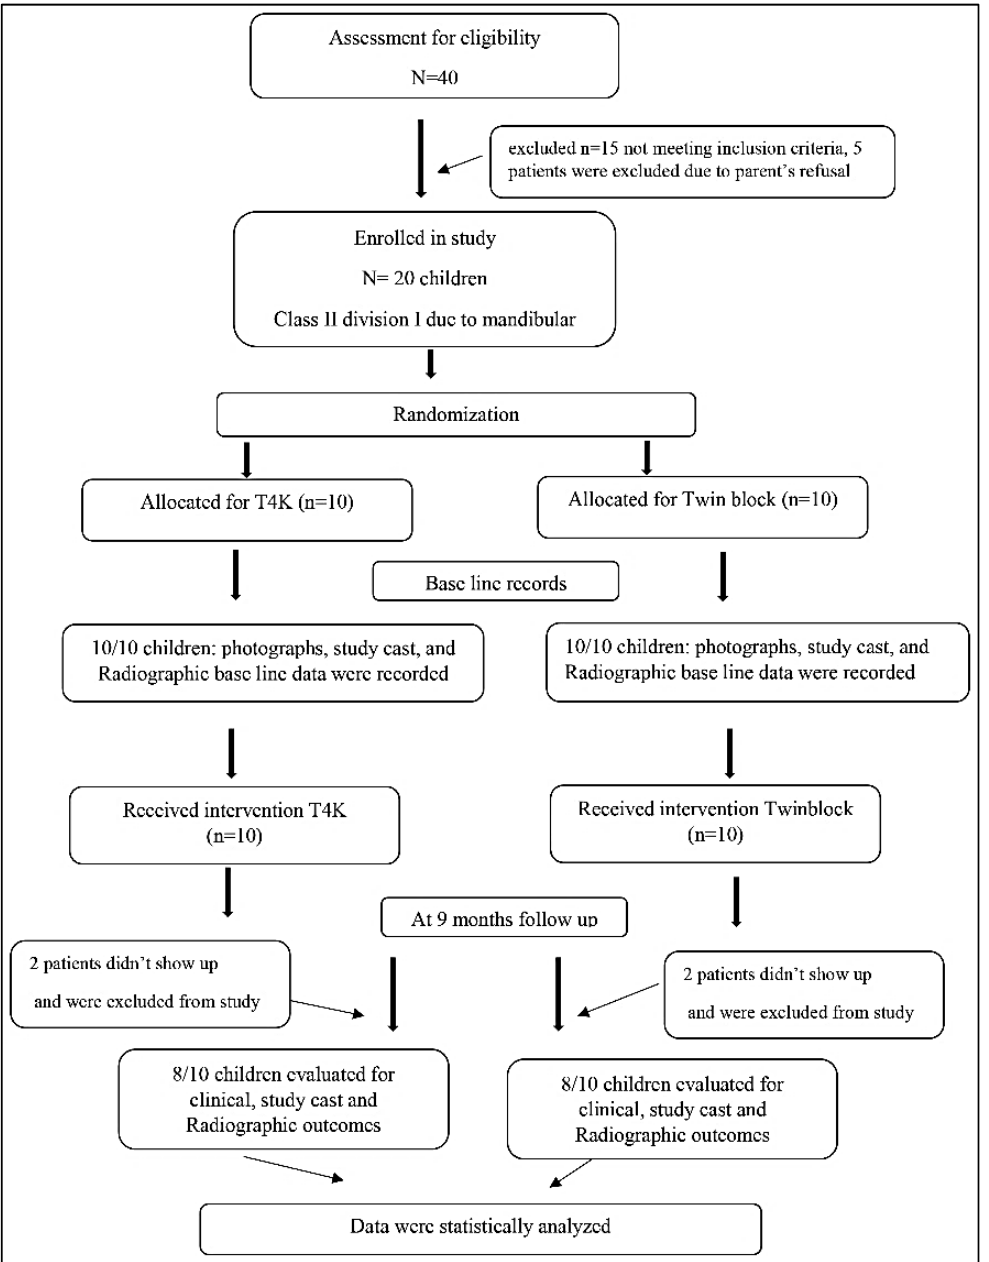
Figure 2. Consolidated Standard of Reporting Trials (CONSORT) diagram showing study protocol up to 9-month follow up. Table 1. Mean dentoalveolar angular (degrees) and linear measurements before intervention in Group I and Group II.